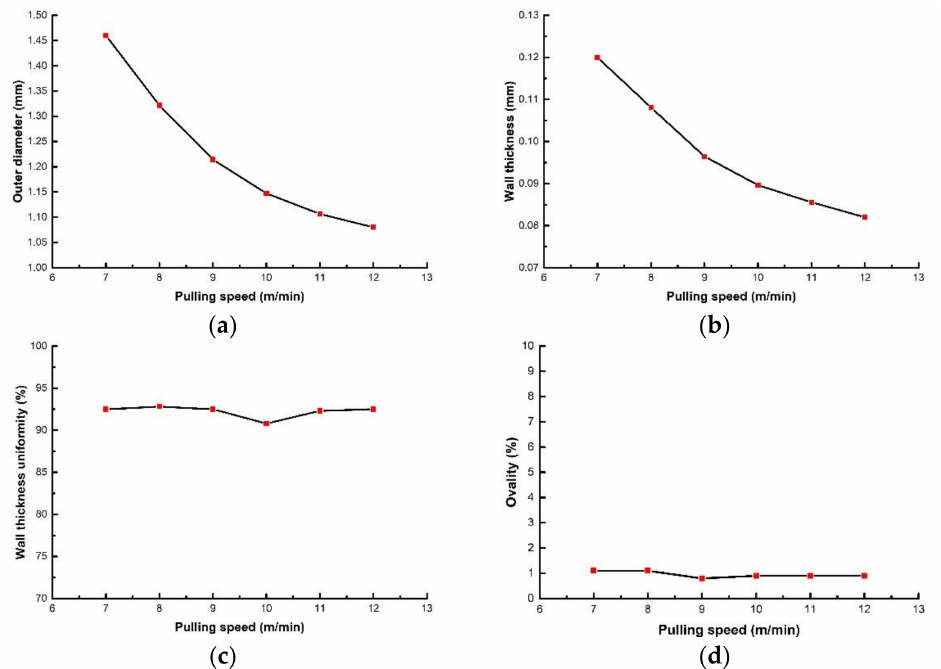
Figure 9. The relationships between evaluation index with pulling speed: ( a ) The relationship between outer diameter with pulling speed; ( b ) The relationship between wall thickness with pulling speed; ( c ) The relationship wall thickness uniformity with pulling speed; ( d ) The relationship between ovality with pulling speed.